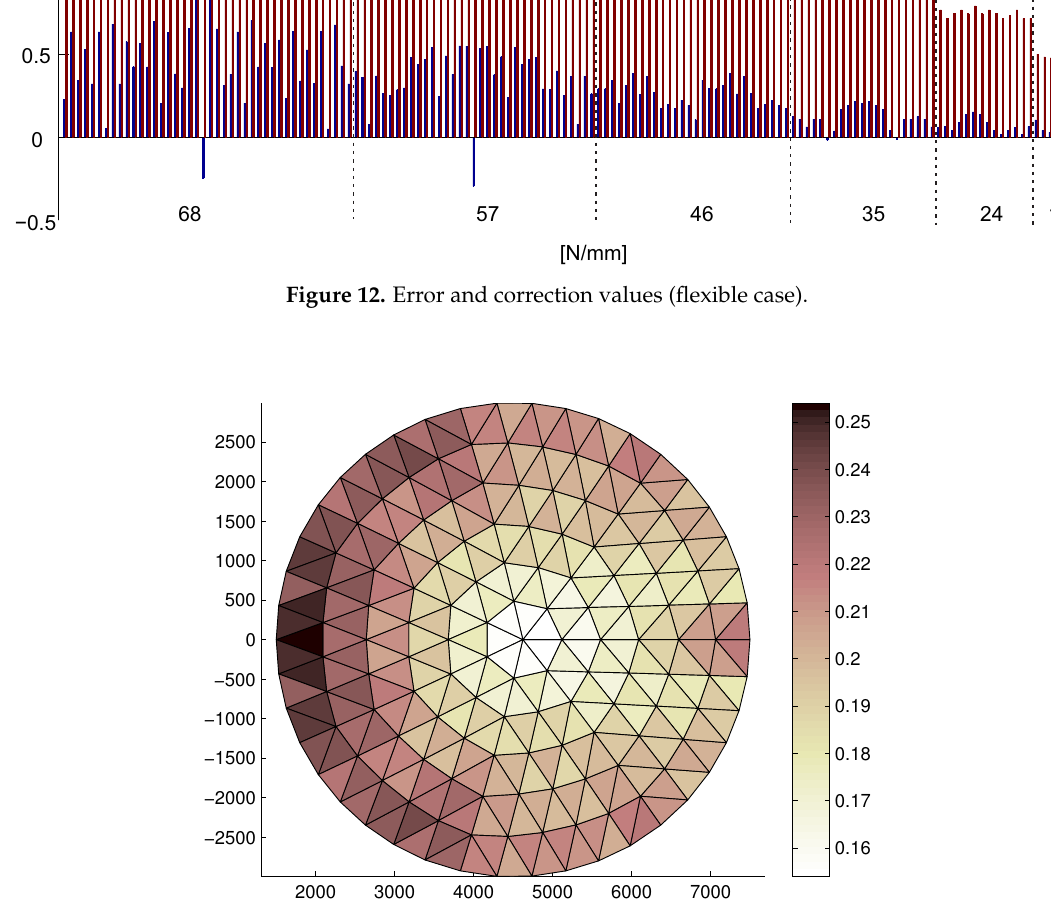
Figure 13. Faceting error (mm) distribution on the front tension truss, obtained for the flexible ring truss